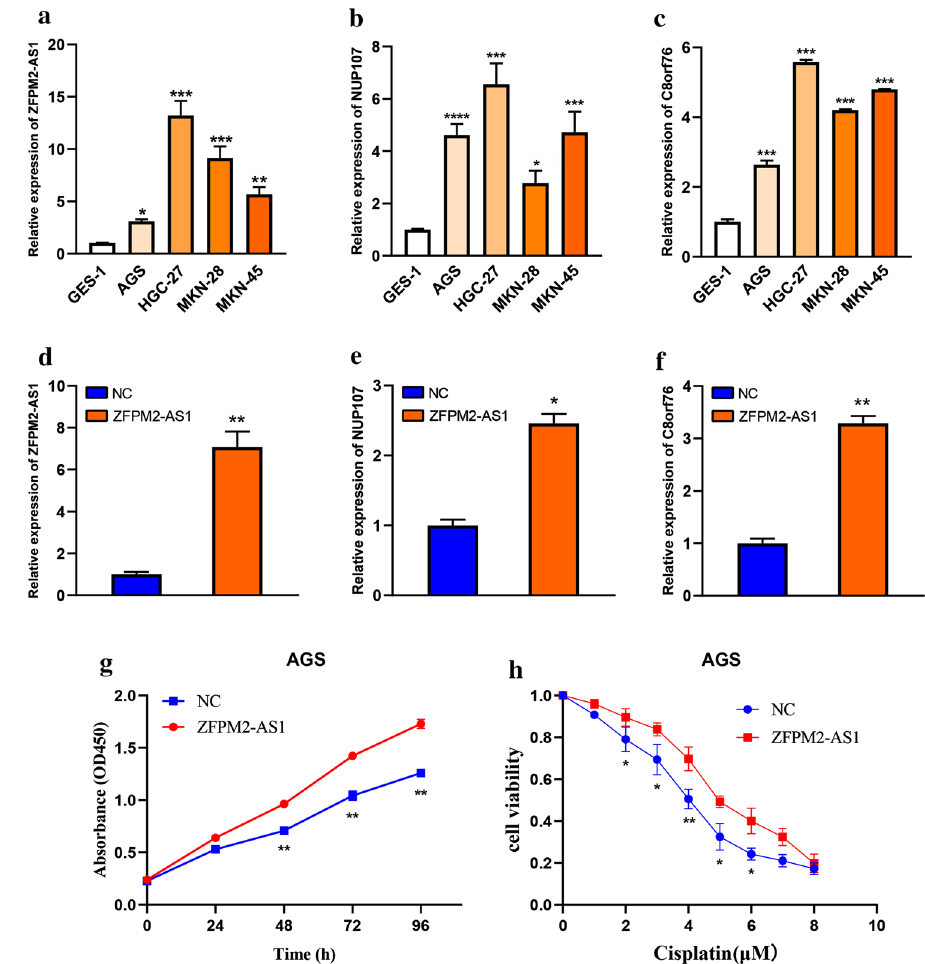
Fig. 12 The expression of ZFPM2-AS1, NUP107, and C8orf76 in GC cells. a qRT-PCR validation of ZFPM2-AS1 expression in GC cells. b qRT-PCR validation of NUP107 expression in GC cells. c qRT- PCR validation of C8orf76 expression in GC cells. d ZFPM2-AS1 expression in AGS cells after transfecting ZFPM2- AS1 plasmid. e NUP107 expression in AGS cells after overexpressing ZFPM2-AS1. f C8orf76 expression in AGS cells after overexpressing ZFPM2-AS1. g The prolifera- tion capacity of AGS cells after ZFPM2-AS1 overexpression. h The sensitivity to cisplatin in AGS cells after ZFPM2-AS1 overexpression. * P < 0.05, ** P < 0.01, *** P <